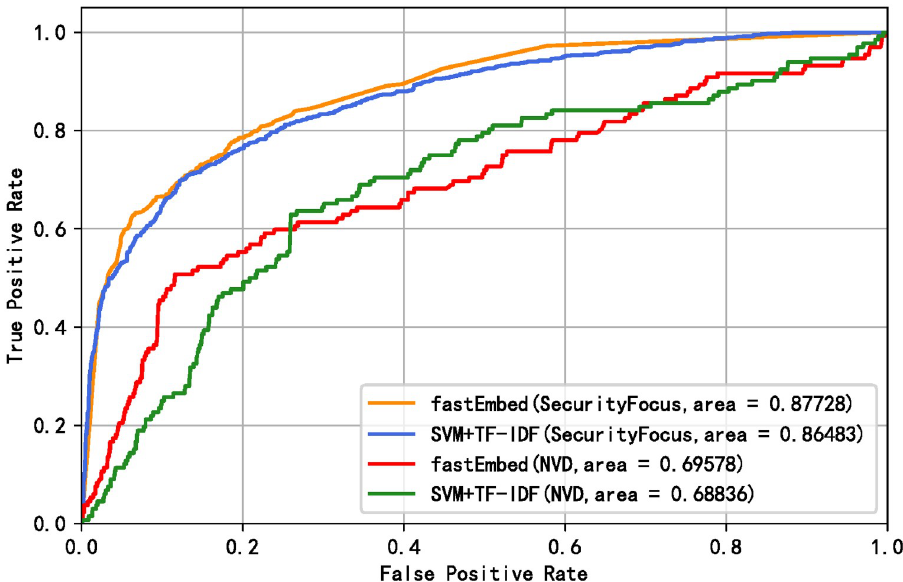
Fig 9. ROC curve of baseline model and fastEmbed without temporal